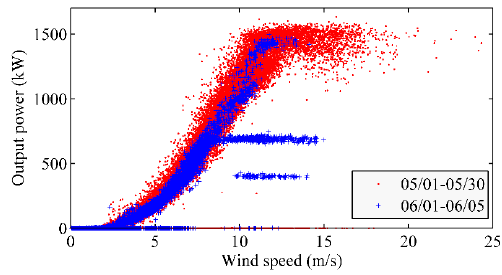
Figure 8. Relationship between WT output power and wind speed during two time periods.